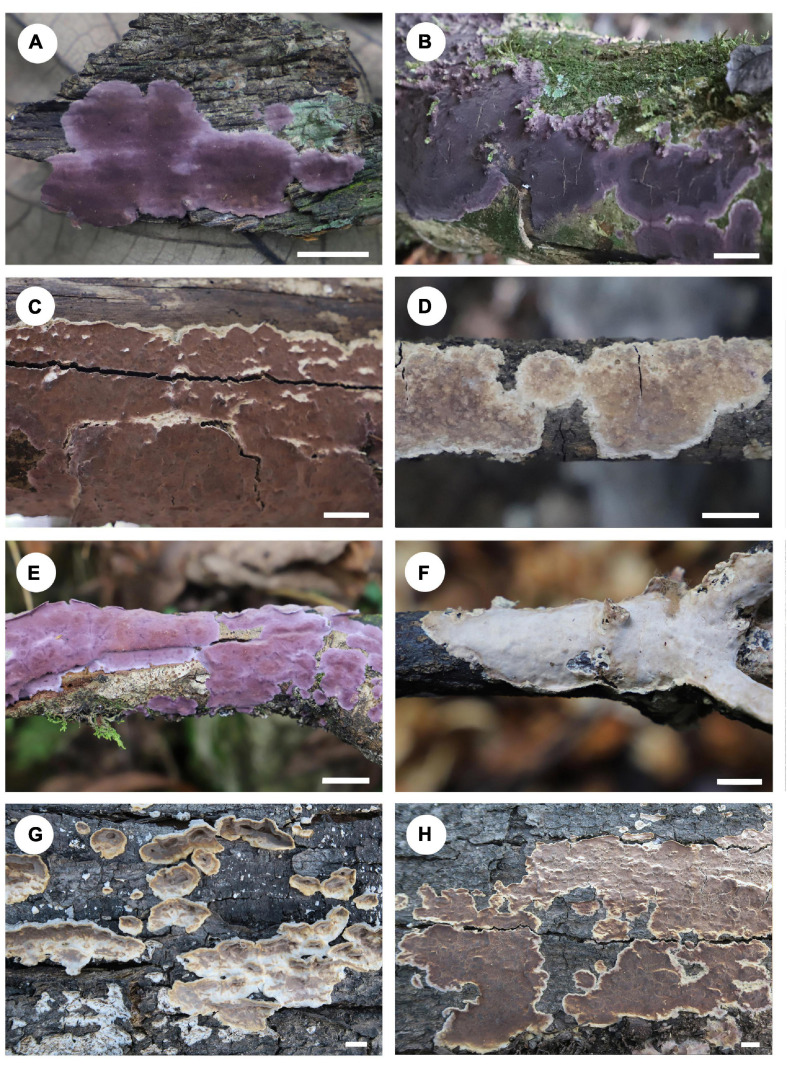
Basidiomata of Phlebiopsis crassa s.l. (A–D: P. crassa group A, E–H: P. crassa group B; scale bars: A–H = 1 cm). (A) He 5855; (B) He 6303; (C) He 6300; (D) He 6301; (E) He 6266; (F) He 5866; (G,H) He 3349.